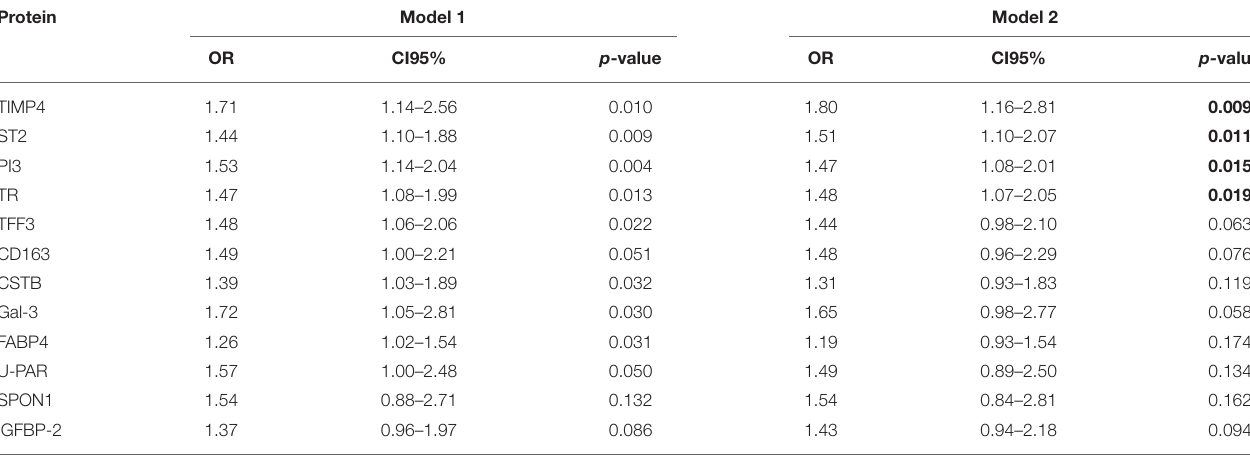
TABLE 4 | Logistic regression analysis examining the association of proteins predictive of cardiovascular disease to physical inactivity (up to 1h vs. more than 1h a week).